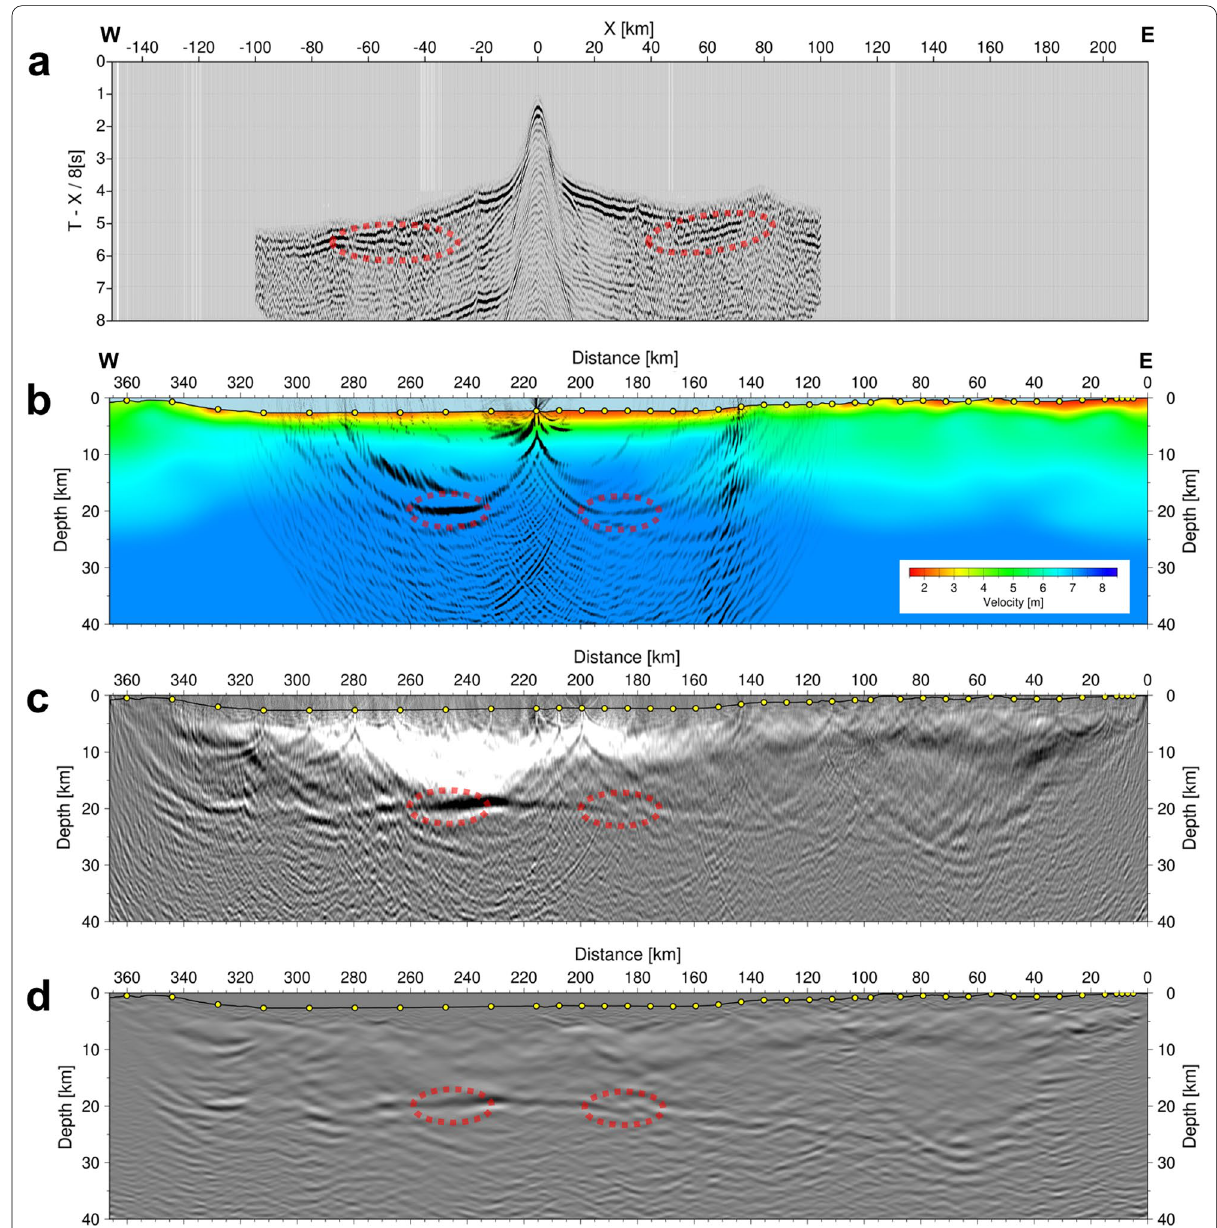
Fig. 2 Example of the RTM imaging procedure along line SJ1901. a Preprocessed record and b RTM image section of the OBS record at No. 30, which overlaid with the migration velocity model. c Raw stacked result of RTM sections from all OBSs, and d the final filtered RTM image. The red dashed line circles denote approximate locations of the Moho reflections identified on the OBS record at No. 30 along